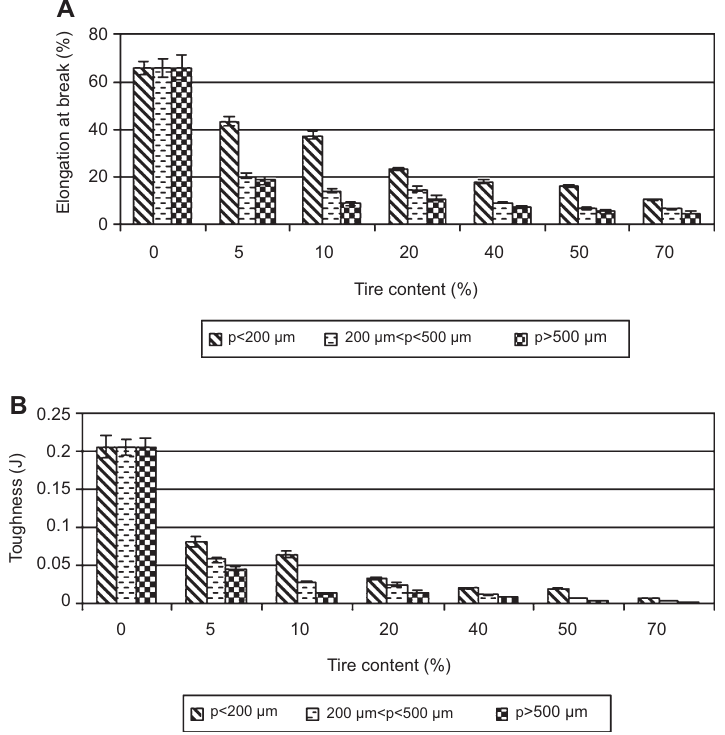
Figure 4 (A) Elongation at break (%) and (B) toughness (J) for different concentrations and particle sizes of